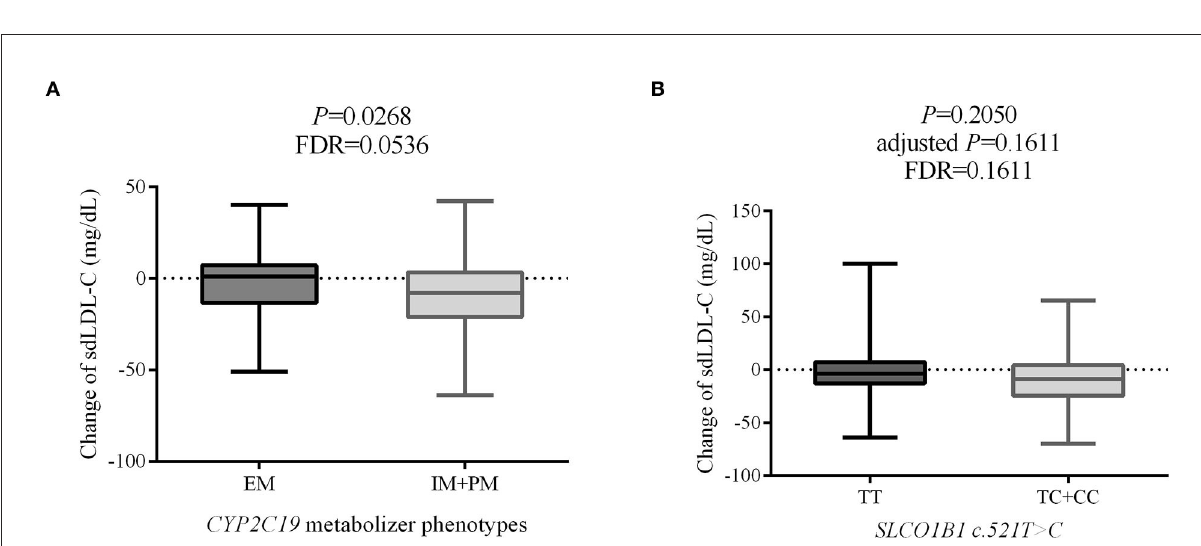
FIGURE6 The effect on sdLDL-C lowering efficacy of statins of CYP2C19 metabolizer phenotypes (A) and SLCO1B1c.521T > C genotypes (B) . sdLDL-C, small dense low-density lipoprotein cholesterol; EM, extensive metabolizer; IM, intermediate metabolizer; PM, poor metabolizer; FDR, false discovery